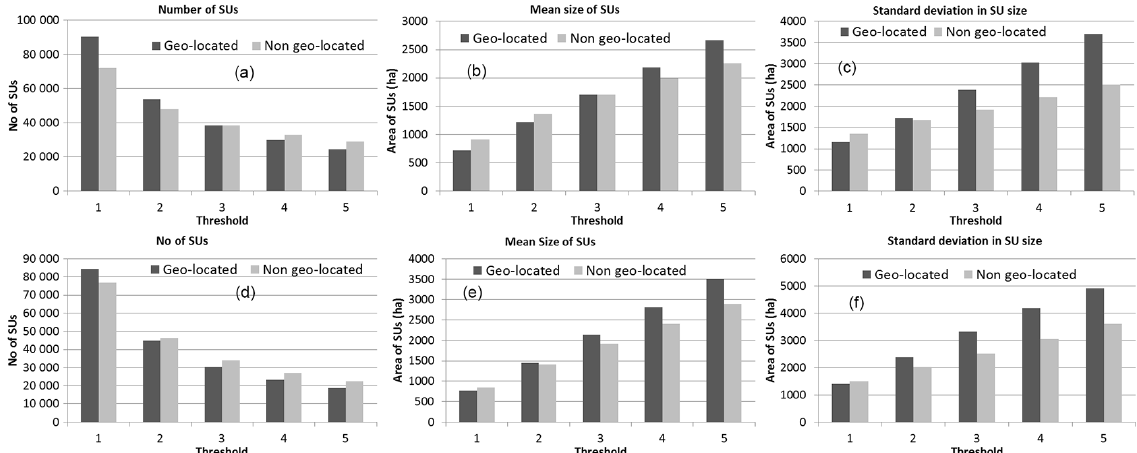
Figure 8. Comparison of the geo-located (black) versus non-geo-located (gray) SUs derived based on elevation, slope and aspect using the global (a–c) and local (d–f) methods, in terms of their sensitivity to different values of area threshold for the total number of SUs, average SU size and standard deviation in SU size over the study domain.